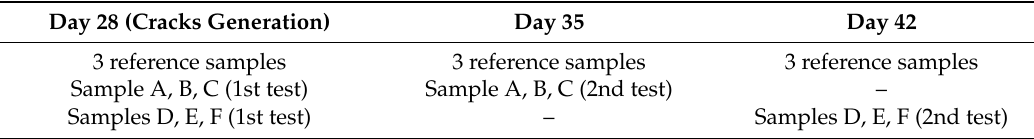
Table 6. Regained compressive strength test